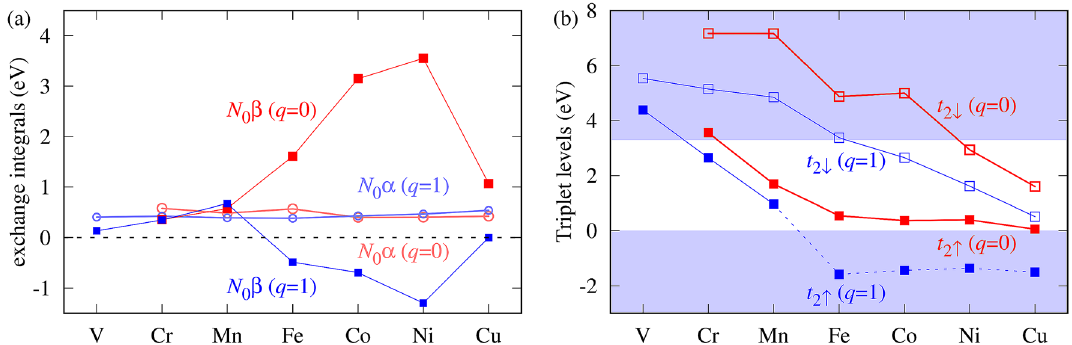
Figure 2. ( a ) The exchange constants N 0 α and N 0 β , ( b ) the triplet levels of TM ions in ZnO for both q = 0 and q = + 1 charge states. The weighted average values of N 0 β and t 2 σ are shown. The resonances in the valence band are shown only schematically.